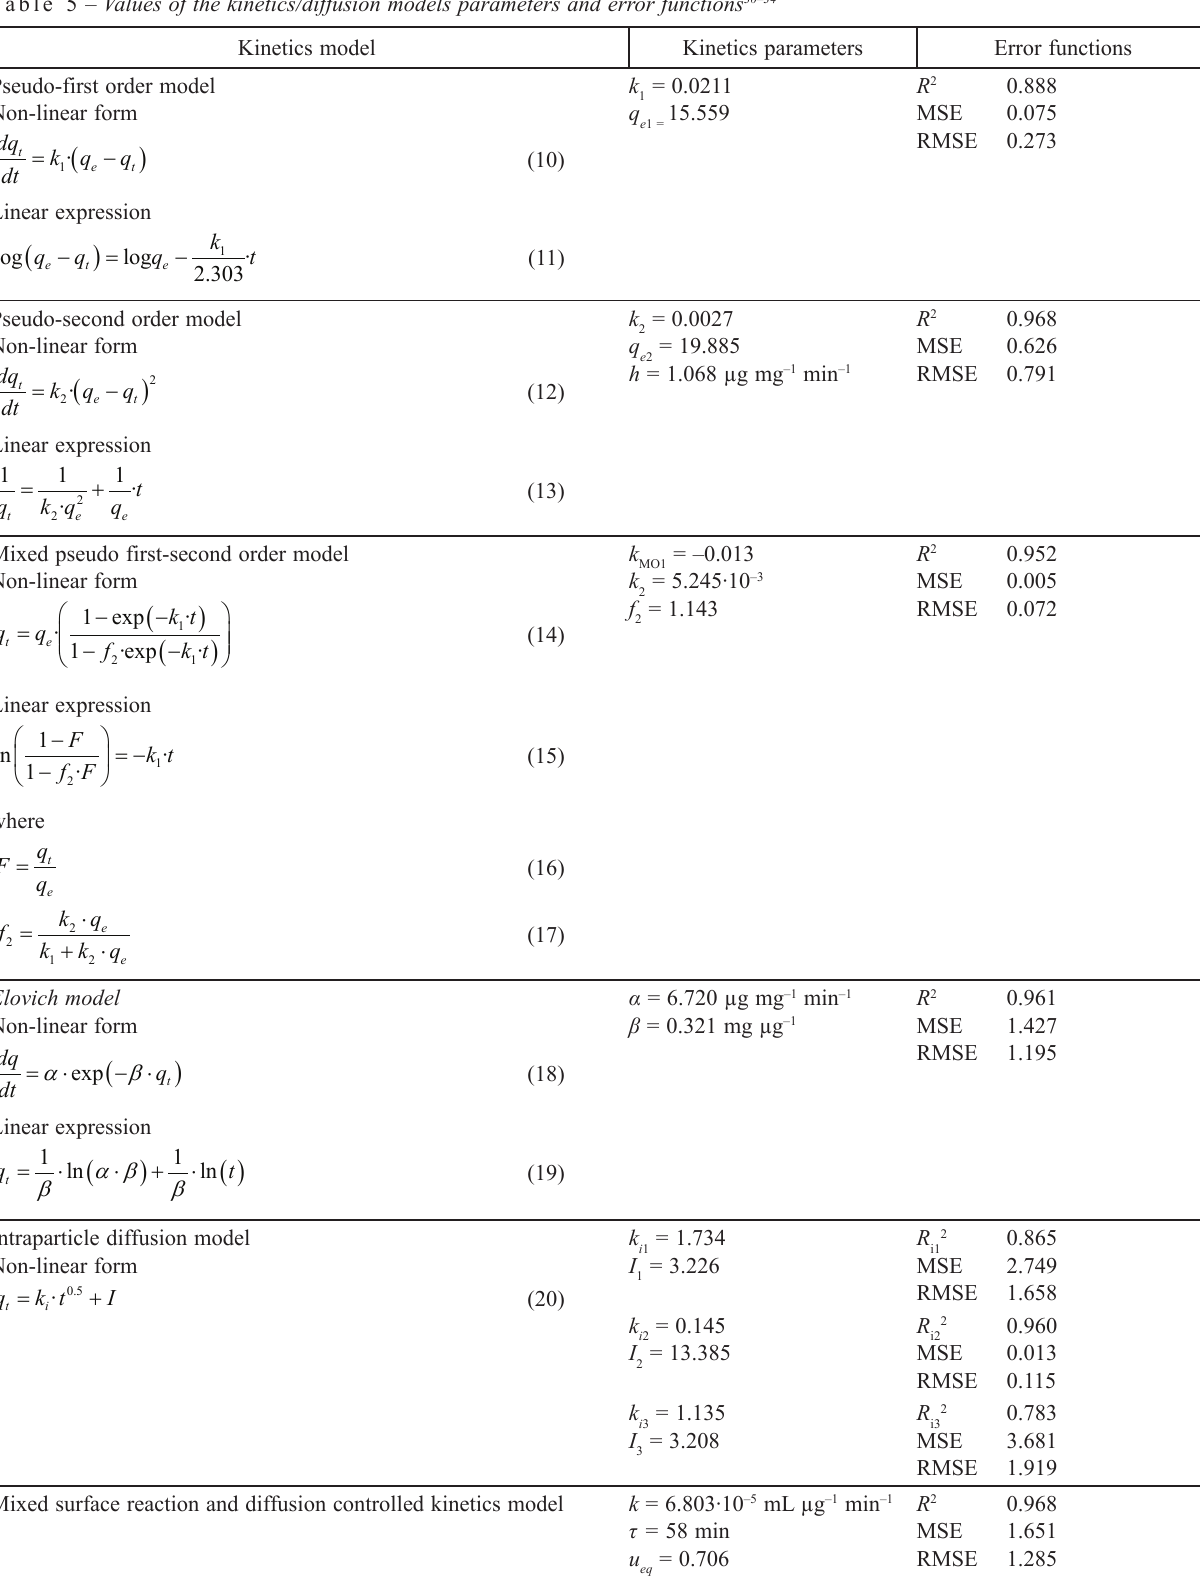
Table 5 – Values of the kinetics/diffusion models parameters and error functions 30–34